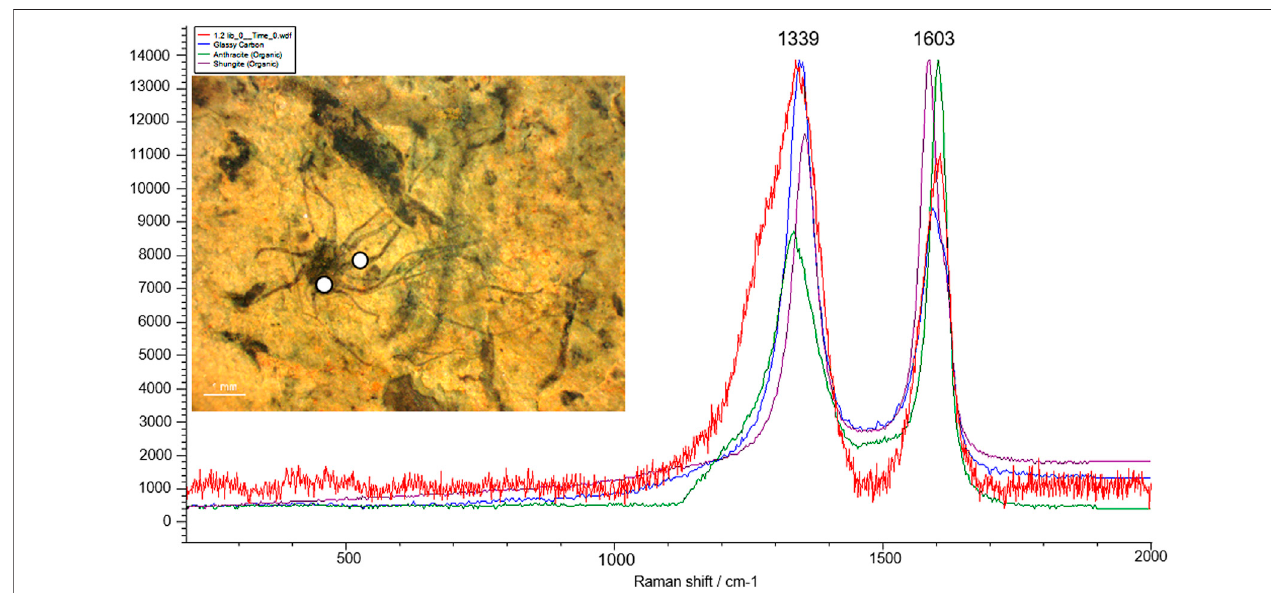
FIGURE 8 | Micro-Raman spectra of the Singhora carbonaceous fossil Palaeoscytosiphon shuklaii re fl ecting the concentration of D (disorder) and G (Graphite) band. Specimen no. BSIP 41897, Scale bar is 2.0 mm.